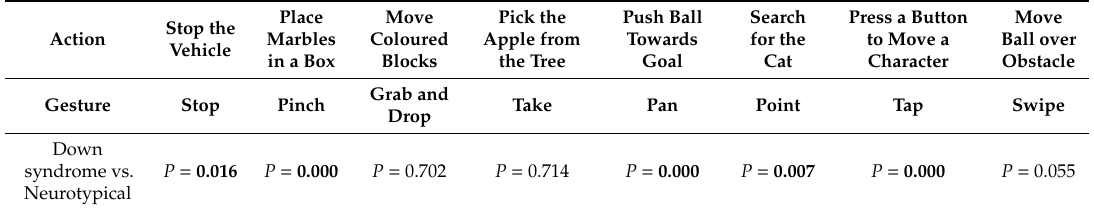
Table 5. Comparison of tasks by completion time.